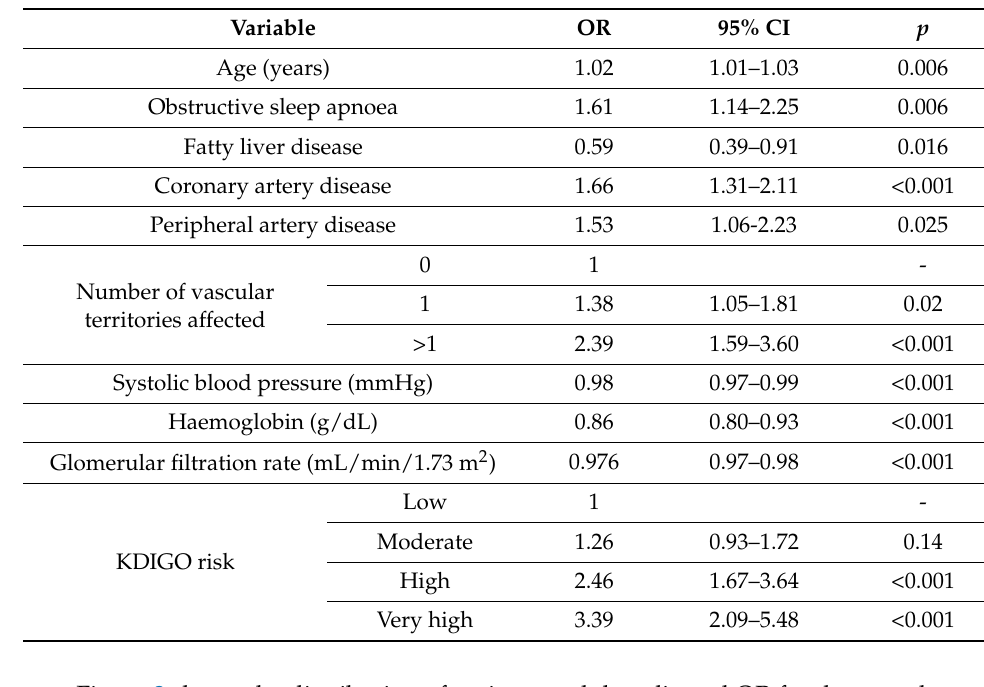
Table 3. Independent variables (multivariate analysis) associated with the risk of HF at the inclu- sion visit.